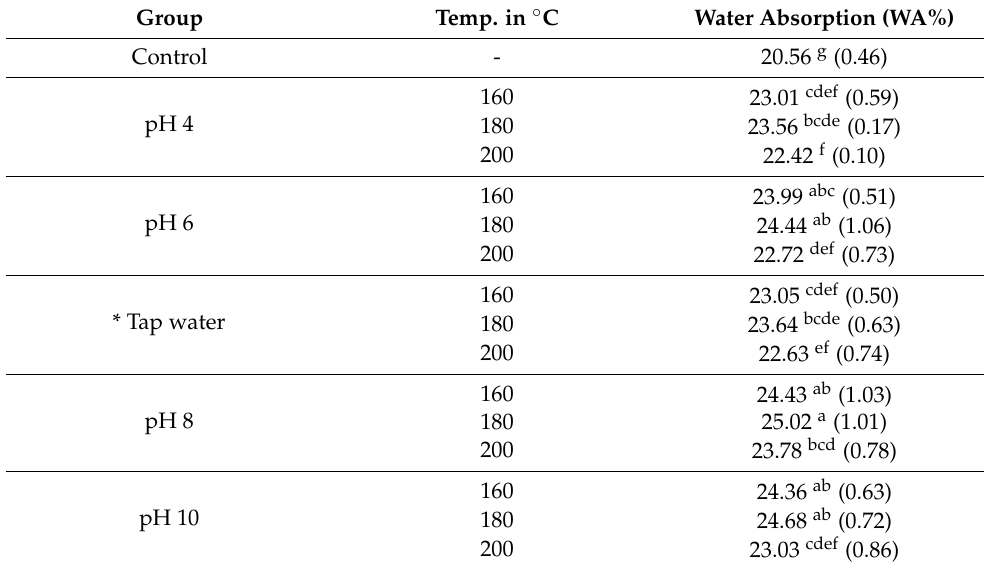
Table 5. WA of treated and untreated samples of rubberwood.